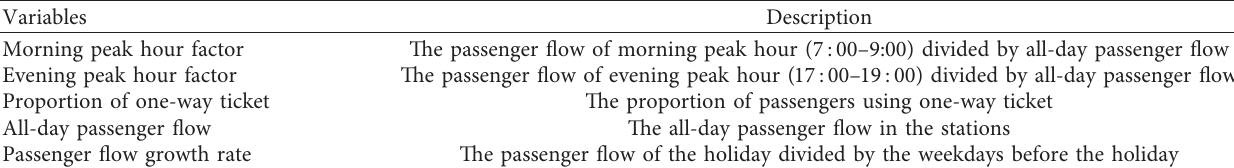
Table 2: The variables for K -means.